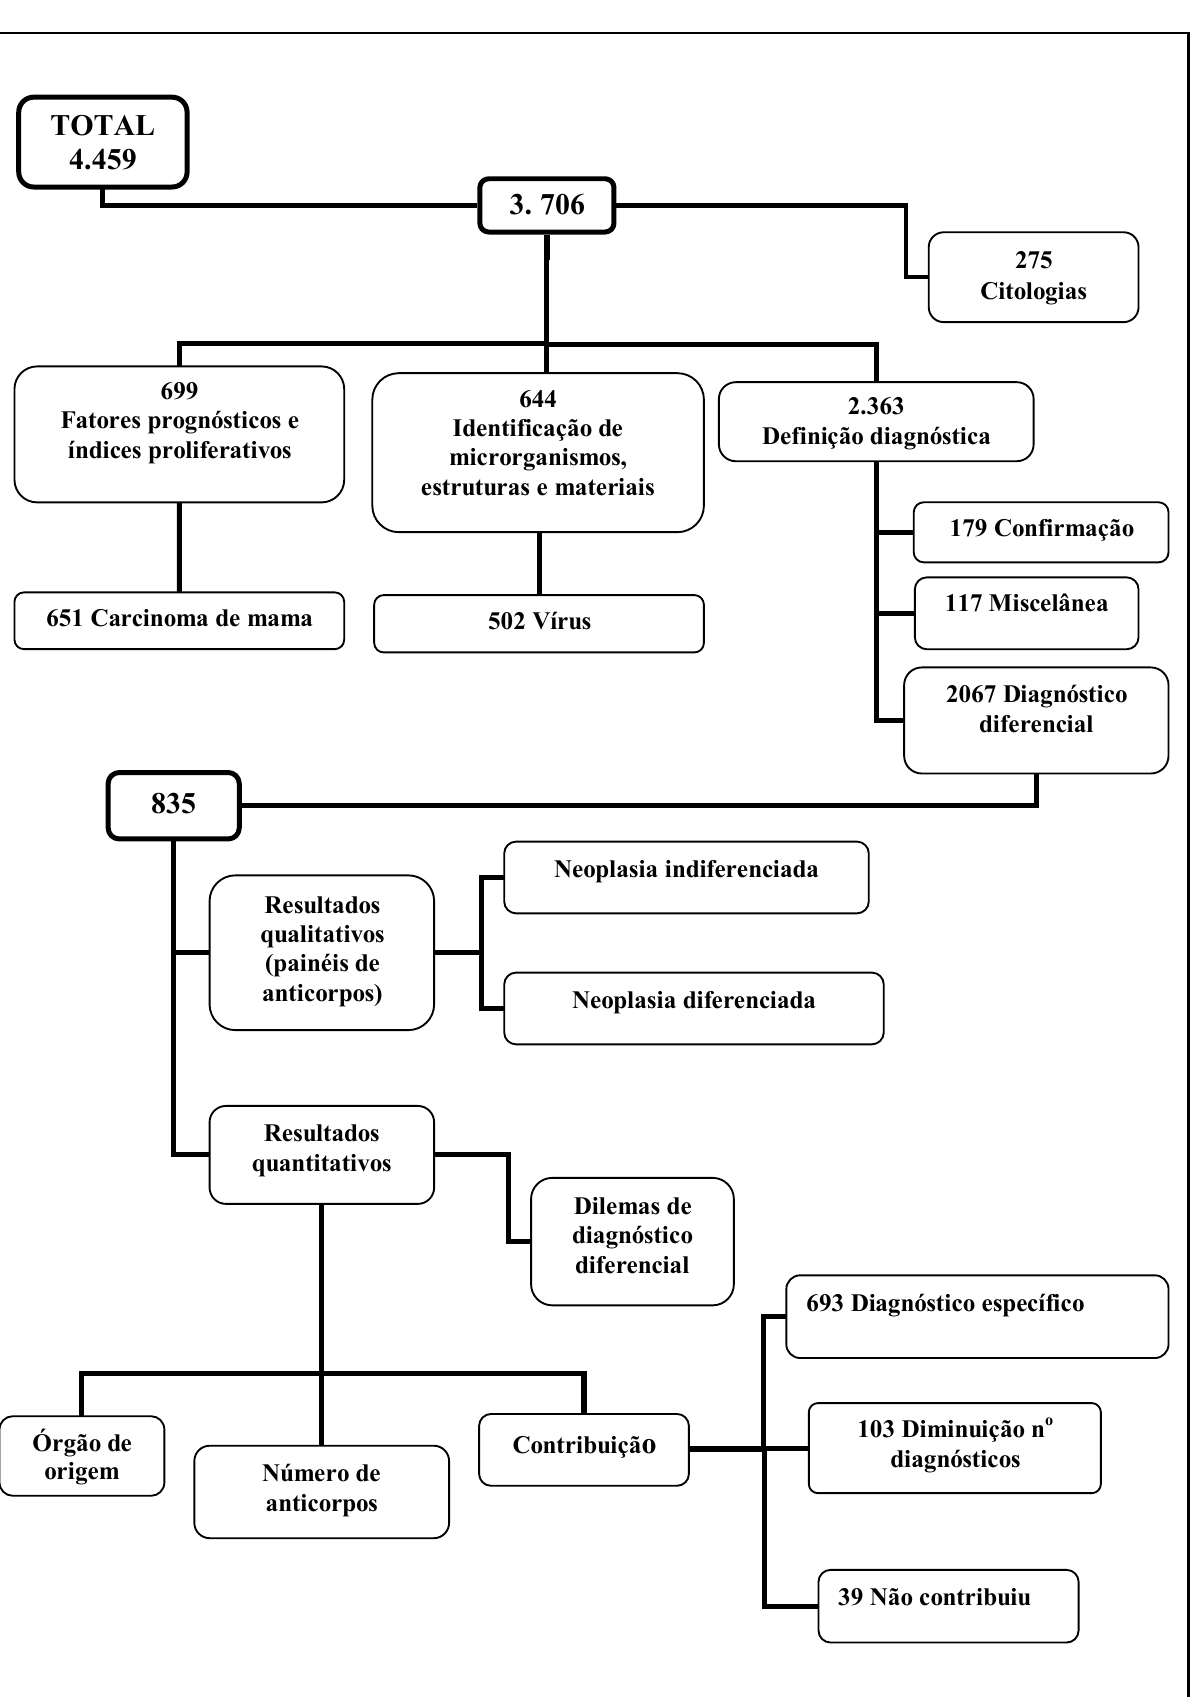
Figura 1 – Organograma dos resultados: maneira pela qual os dados foram classificados, analisados e